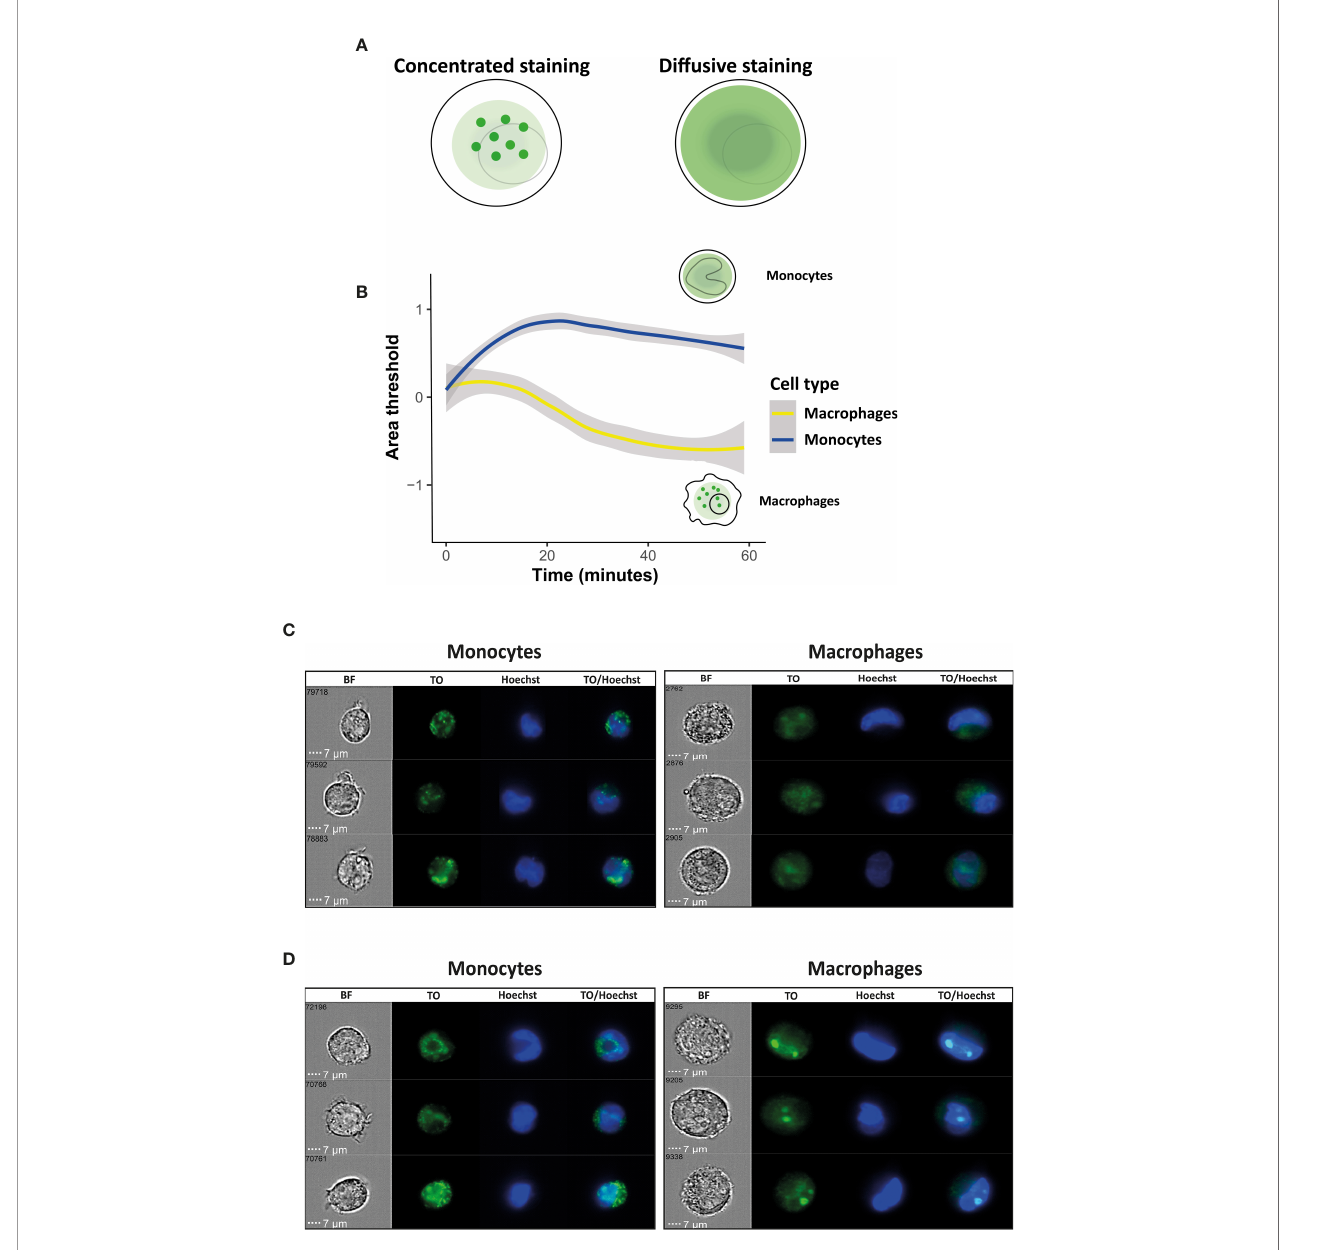
FIGURE 3 | Kinetic measurement of the signal of EV RNA staining Area threshold inside recipient monocytes or macrophages. Pf -derived EVs were labeled by Thiazole orange (TO), and their uptake into monocytes and macrophages was measured for 1 hour. (A) Schematic representation of the Area Threshold feature. (B) Graph representing change in area threshold of the fl uorescent signal inside the recipient cells over time. Cell types were compared with a linear mixed effects model, with cell type and time as fi xed factors, and sample ID as a random factor. Statistics were done in R, v. 4.0.4, using the package ‘ lmerTest ’ . For calculating changes relative to the starting point, a log2-fold change was calculated per each point, relative to its own sample ’ s average value of the fi rst 1.5 minutes. Grey area around the lines represents 95% con fi dence intervals, p<0.001. (C) Signal detected by IFC from three representative recipient cells of monocytes and macrophages at the fi rst 10 minutes of the uptake. (D) Signal detected by IFC from three representative recipient cells of monocytes and macrophages at 1 hour post uptake. BF-bright fi eld, TO-thiazole orange, Hoechst-nuclear